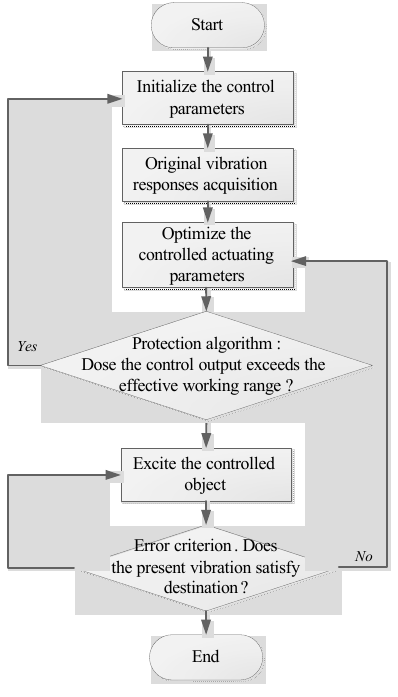
Figure 5. Flow chart of the control process.